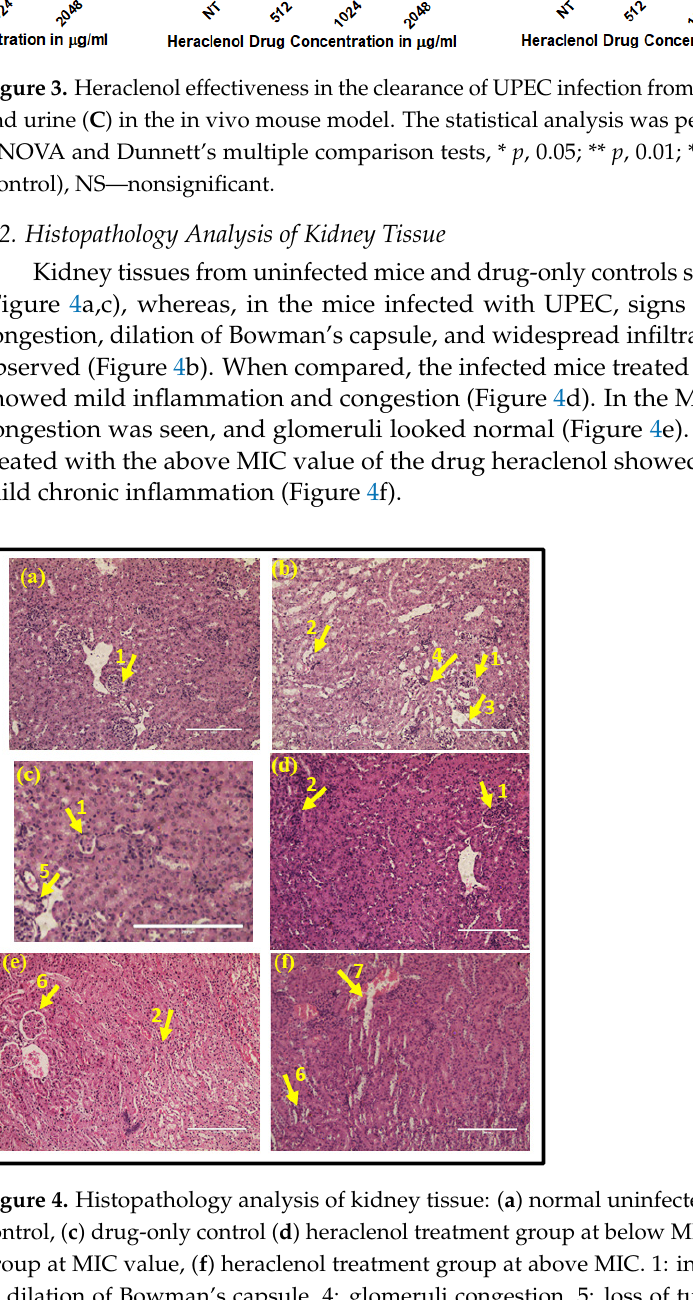
Figure 3. Heraclenol effectiveness in the clearance of UPEC infection from the bladder ( A ), kidney ( B ), and urine ( C ) in the in vivo mouse model. The statistical analysis was performed by using one-way ANOVA and Dunnett’s multiple comparison tests, * p , 0.05; ** p , 0.01; *** p , 0.001; NT—not tested (control), NS—nonsignificant.